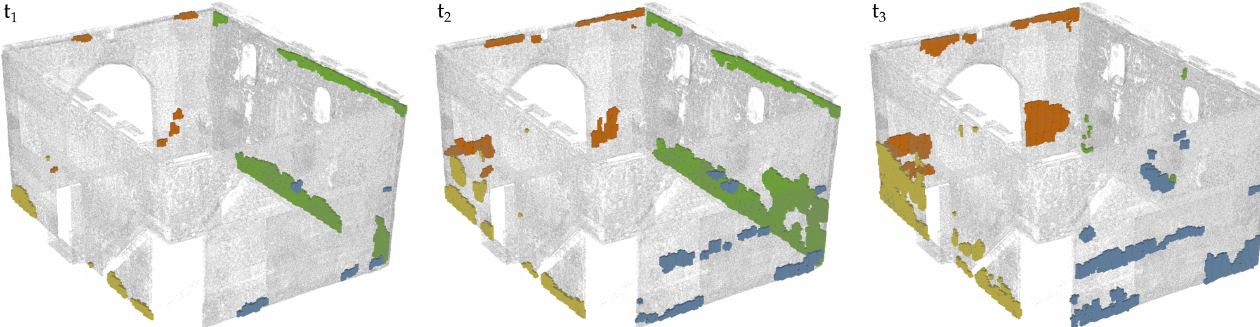
Figure 10. Voxelised ( d v = 5cm) and assigned damages of each annotated state for the wall elements ( d min = 20cm, p min = 25%) in the case study dataset: Wall 01 (yellow), Wall 02 (blue), Wall 03 (green), and Wall 04 (orange).